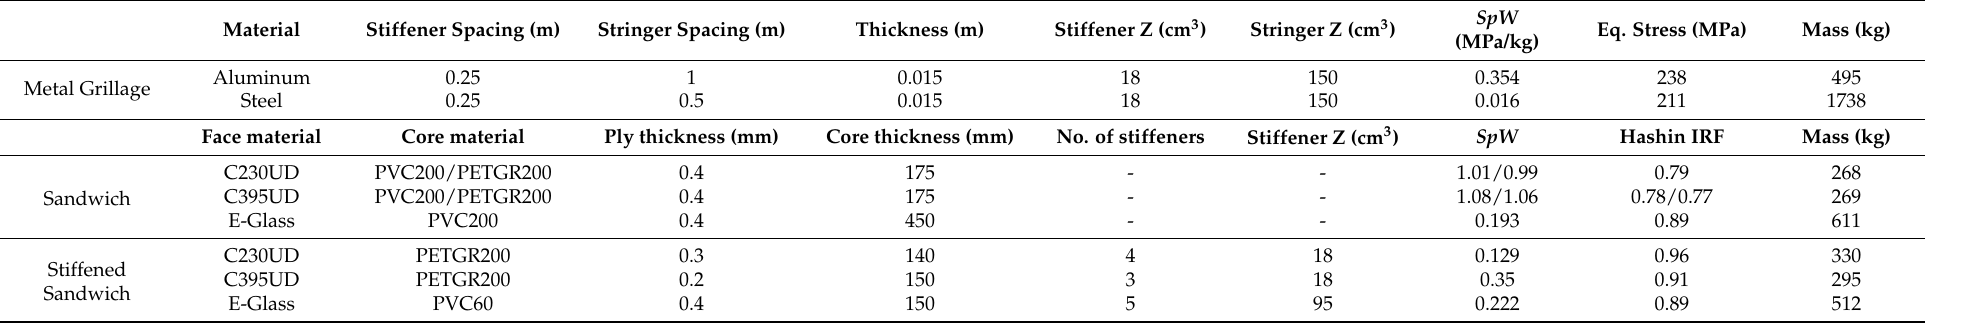
Table 7. Best parametric combinations by material in terms of SpW and mass.